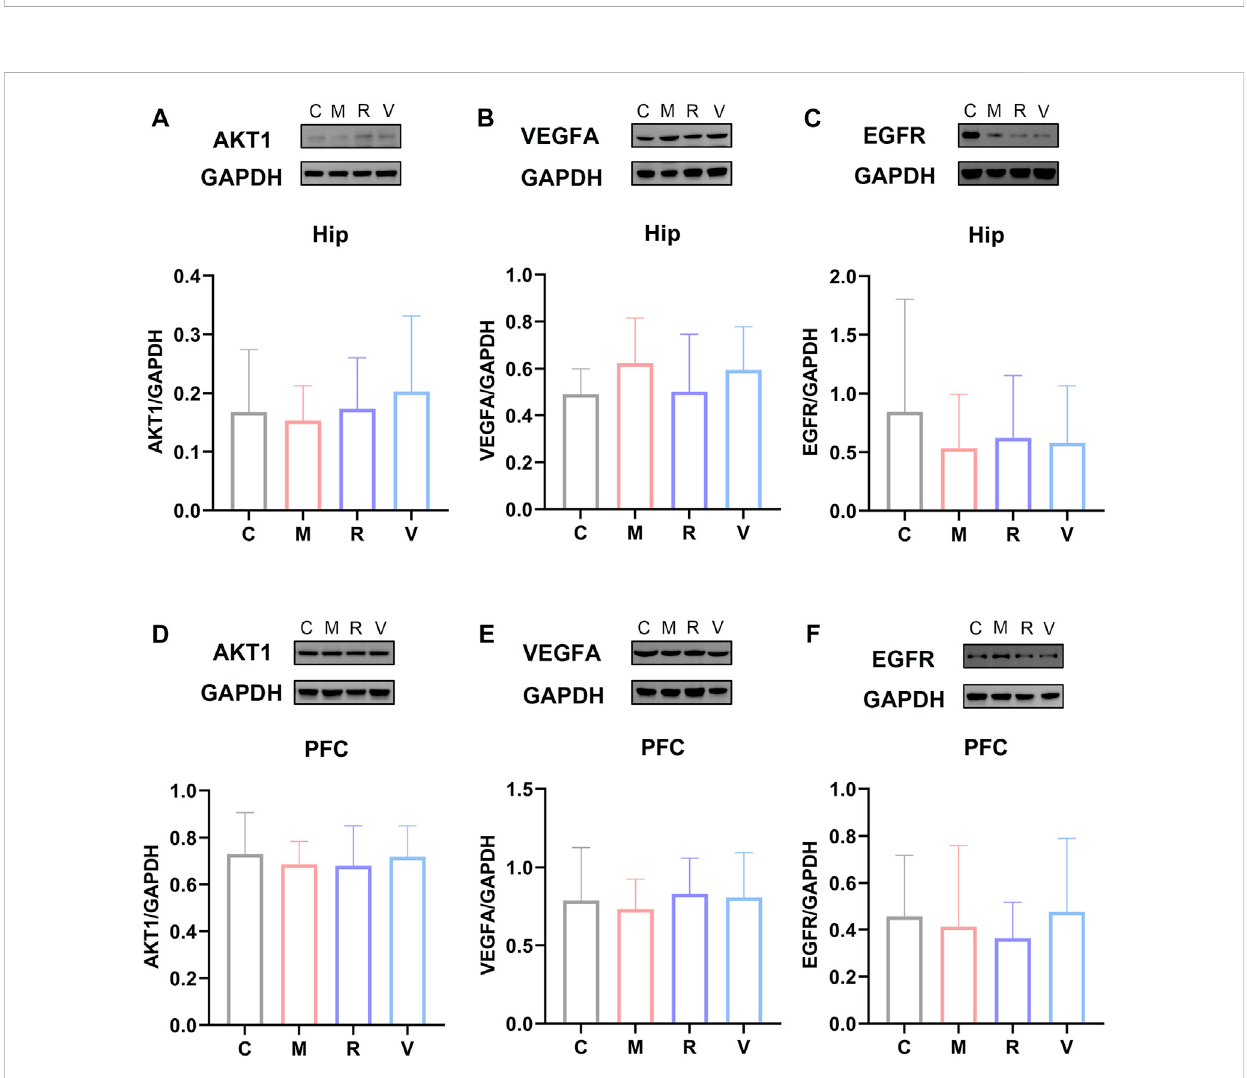
FIGURE 10 Relative protein expression of AKT1 (A) , VEGFA (B) , and EGFR (C) in the hippocampus. Relative protein abundance of AKT1 (D) , VEGFA (E) and EGFR (F) in the prefrontal cortex. C: Control group, M: CFS group, R: CFS + Rg1 group, and V: CFS+ Oryzanol&VB1 group. Data are mean ± standard deviation, n = 6. * p < 0.05, ** p < 0.01 versus Control group; # p < 0.05, ## p < 0.01 versus CFS